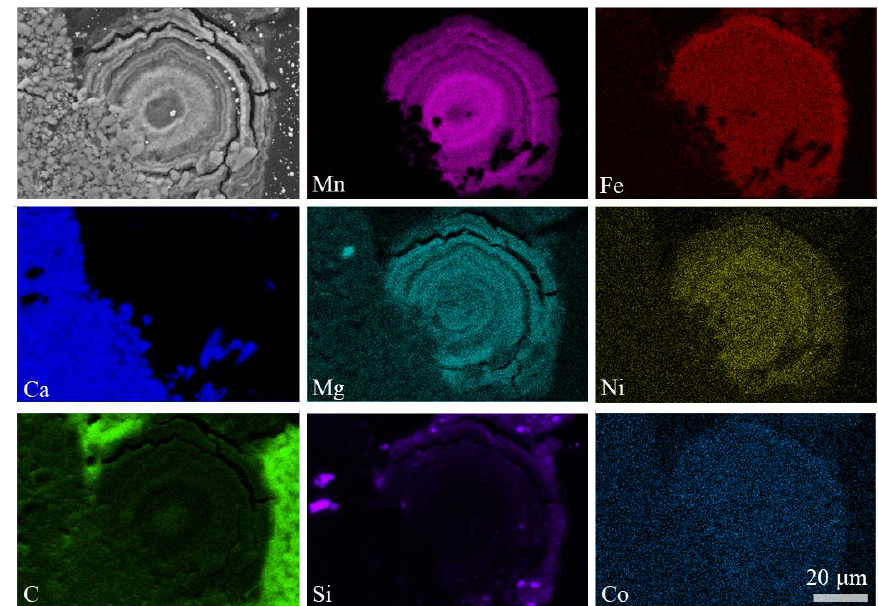
Figure 5. SEM-EDS mapping of different elements within a micro-nodule on a polished thin section. The distribution of Mn perfectly matches that of Ca. The EDS data did not show equal concentration patterns for Mn, Fe, and Co; in contrast to Mn, some Fe concentration was found away from the micro-nodule, but matched with Si. The elemental Mg and Ni were similarly distributed as Mn, while Si was opposite to the gradients of Ca and Mn, having the highest randomly distributed concentration. The distribution of carbon indicated the signature of resin used to prepare the